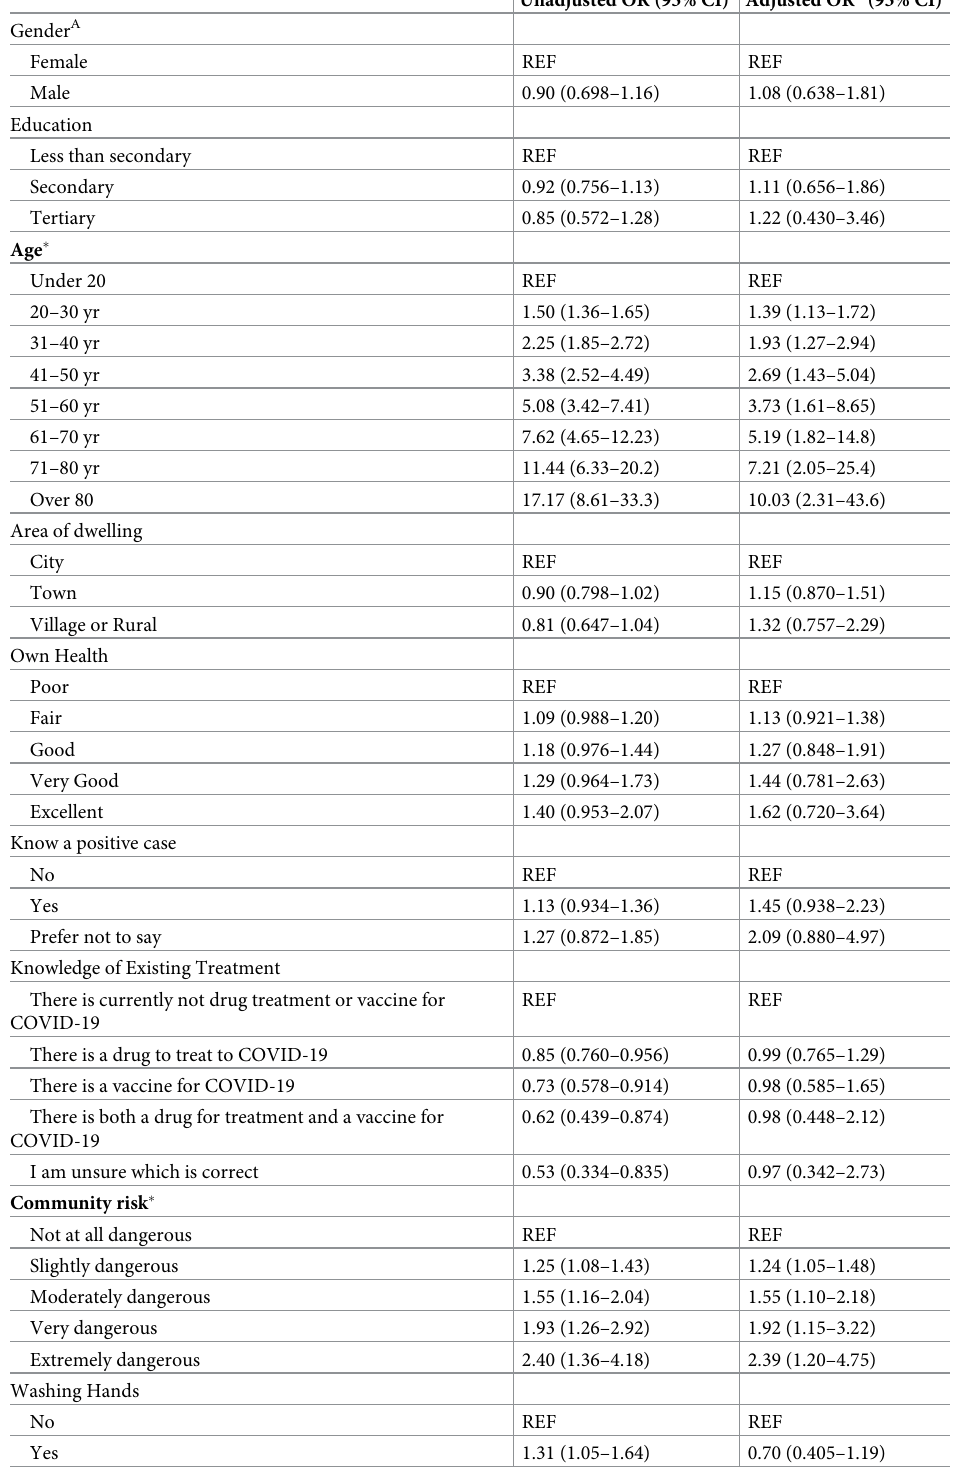
Table 3. Crude and adjusted logistic regression analysis of independent variables of COVID-19 vaccination